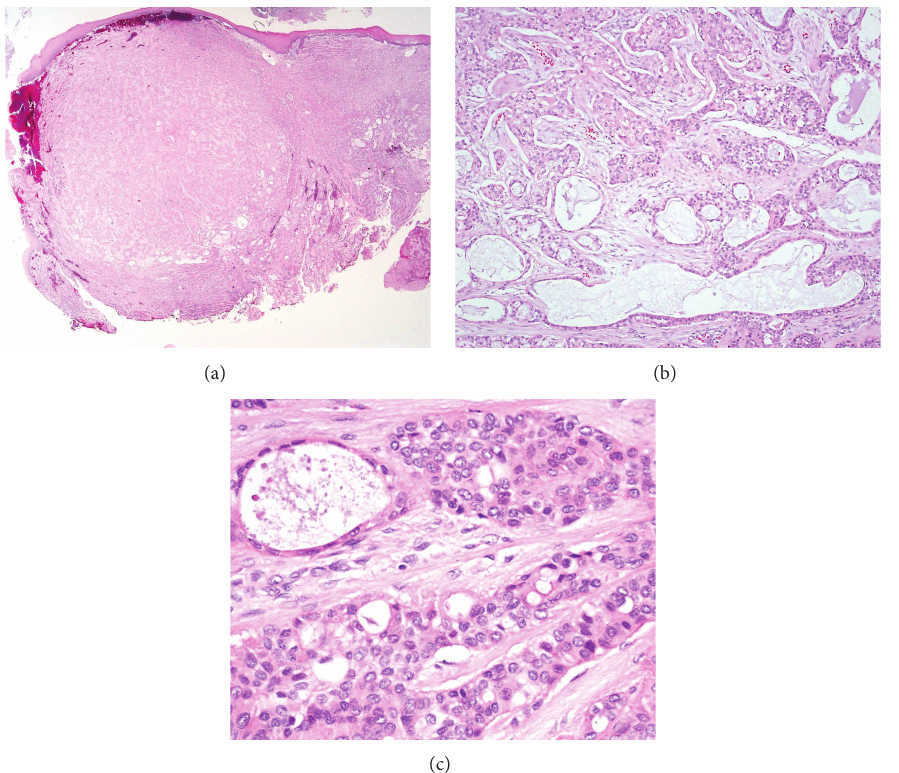
Figure 2: Histologic findings of the tumor. Low-power magnification view, hematoxylin and eosin staining, × 10, showed a well-circum- scribed, but not encapsulated, mass with a variety of different growth patterns (a). Variable architectures were seen within tumor tissue, including tubular, trabecular, and cribriform growth patterns, hematoxylin and eosin staining × 100. The tumor cells were small-to-medium sized and uniform in shape (b). The nuclei of the tumor cells were round to oval, with vesicular pale nuclear chromatin and small nucleoli. The mitotic figures were inconspicuous, hematoxylin and eosin staining × 400